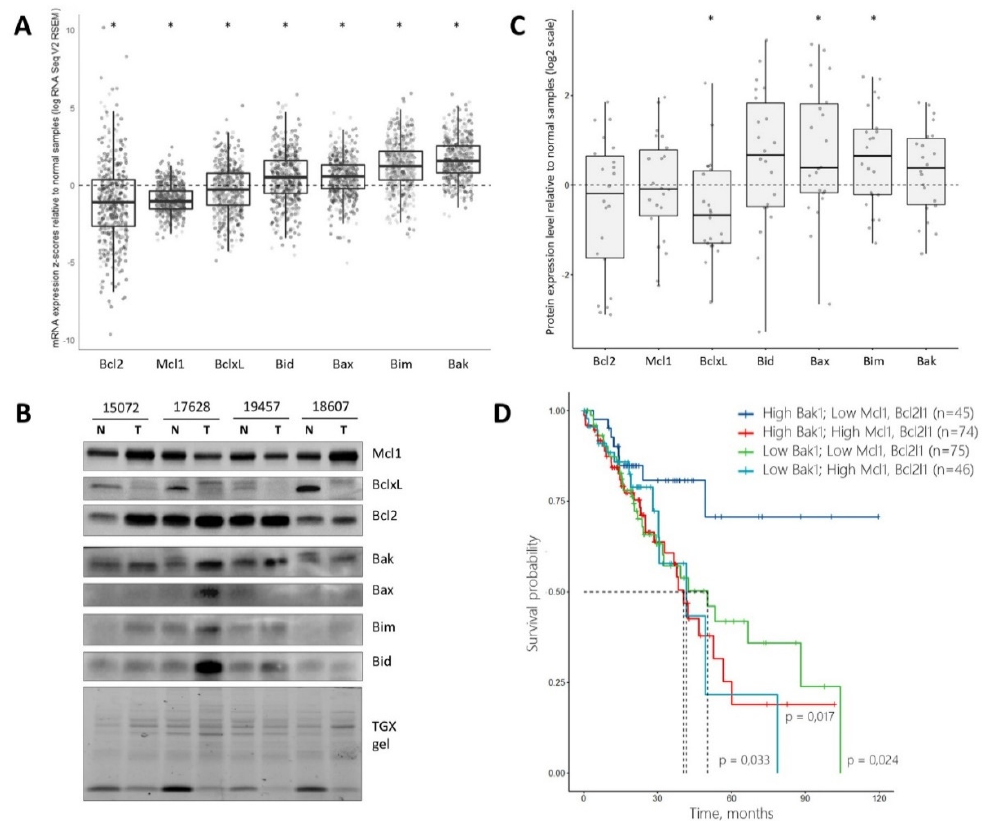
Figure 7. Analysis of Bcl-2 family genes mRNA expression and protein levels in lung adenocarcinoma tissues and the role in patient survival. ( A ) The mRNA expression z-scores in cancer samples relative to normal (log RNA Seq V2 RSEM) based on TCGA dataset (LUAD, TCGA, PanCancer Atlas, n = 510). ( B ) Representative Western blot images showing Bcl-2 family protein levels in clinical samples. Notes: T—lung adenocarcinoma tissues, N—adjacent non-tumorous tissues. TGX stain-free total protein staining is used as a loading control, * p -value < 0.05. ( C ) Densitometry analysis of Bcl-2 family protein levels in tumorous tissues relative to adjacent non- tumorous samples normalized on total protein level. Notes: log2 (TGX normalized protein level in tumor/TGX normalized protein level in adjacent non-tumorous sample ratio), * p -value < 0.05. ( D ) Kaplan–Meier survival curves in four groups with high/low expression level of Bcl2 family genes.